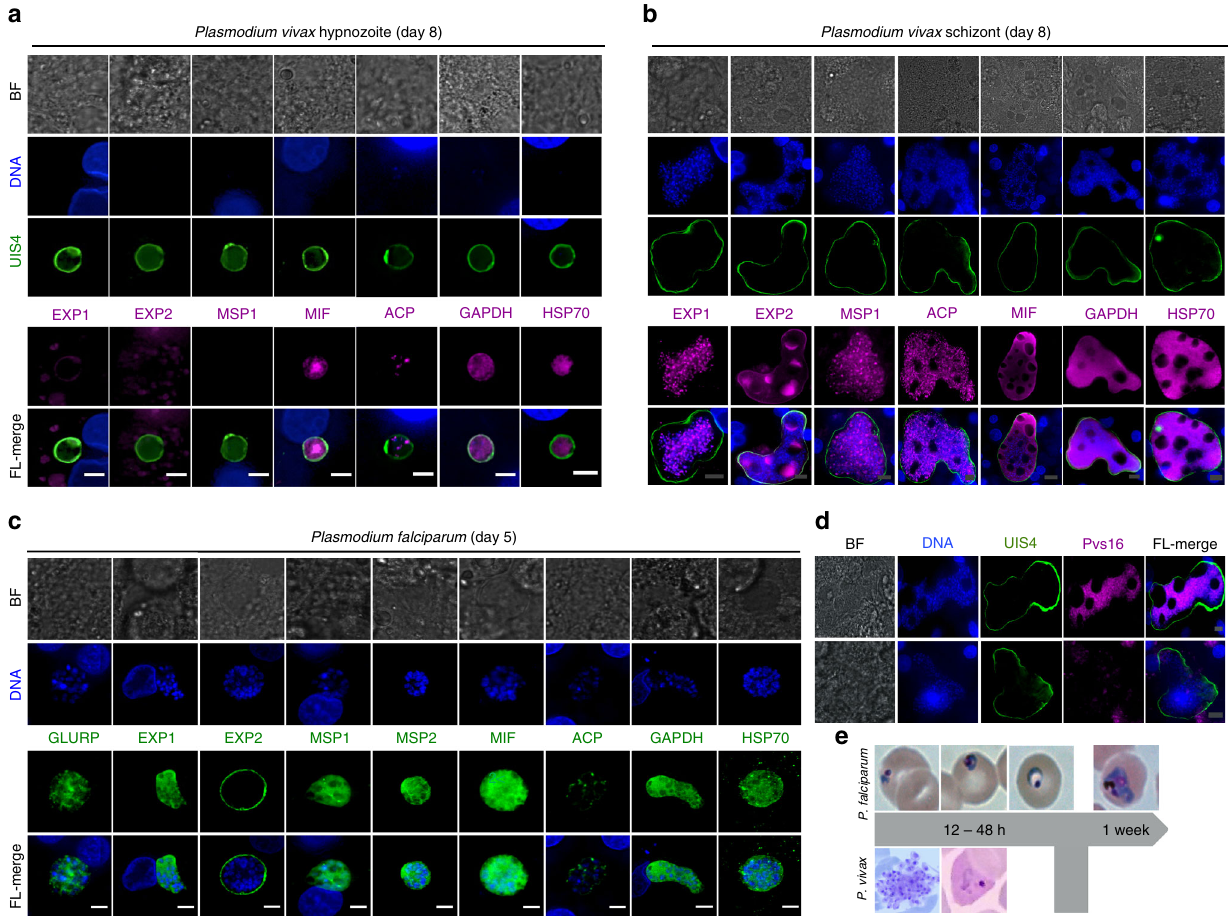
Fig. 4 High-resolution immuno fl uorescent identi fi cation of Plasmodium liver stage (LS) parasites. a High-resolution images of P . vivax hypnozoites demonstrate these forms have minimal nuclear material and are negative for schizogony markers EXP1, EXP 2 and MSP1. Hypnozoites stain positive for cytosolic markers MIF, HSP70, and GAPDH and reveal a functioning apicoplast. b By day 8, P . vivax schizonts are several times larger than the host cell hepatic nucleus, feature genome replication and segmentation, and stain positive for EXP1, EXP2, ACP, and MSP1. c The LS of P . falciparum is shorter than that of P . vivax schizonts; developing parasites are correspondingly less small. By day 5 merozoite segmentation has begun (as noted by ACP staining of separate apicoplasts) but not complete (as noted by diffuse staining of MSPs). d Immuno fl uorescent staining of day 8 P . vivax LS schizonts with anti-Pvs16, a sexual stage-speci fi c biomarker for immature gametocytes, showed co-localization with developing LS merozoites indicated by segmented DNA. However, anti-Pvs16 signal does not appear in every LS. e The PHH system successfully supports complete maturation of Plasmodium LS schizonts measured by breakthrough into blood stage using reticulocyte ( P . vivax , days 9 – 11) or RBC ( P . falciparum , days 7 – 8) overlays with initial giemsa staining every 6 h. P . vivax overlays show formation of merozoite packages which rupture into the reticulocyte culture leading to invasion. Alternatively, no merosomes were captured in P . falciparum overlays but early rings were present within the fi rst 12 h and continued culture progressed to an asynchronous population at > 1% parasitemia. White scale bars represent 5 µ m, gray scale bars represent 10 µ